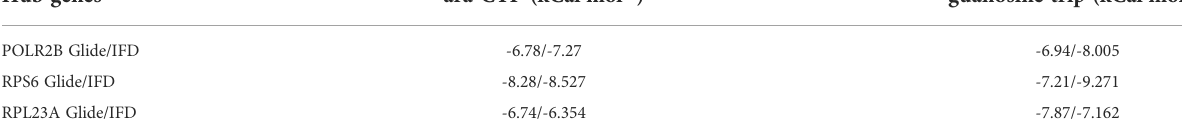
TABLE 2 docking score of drug and hub